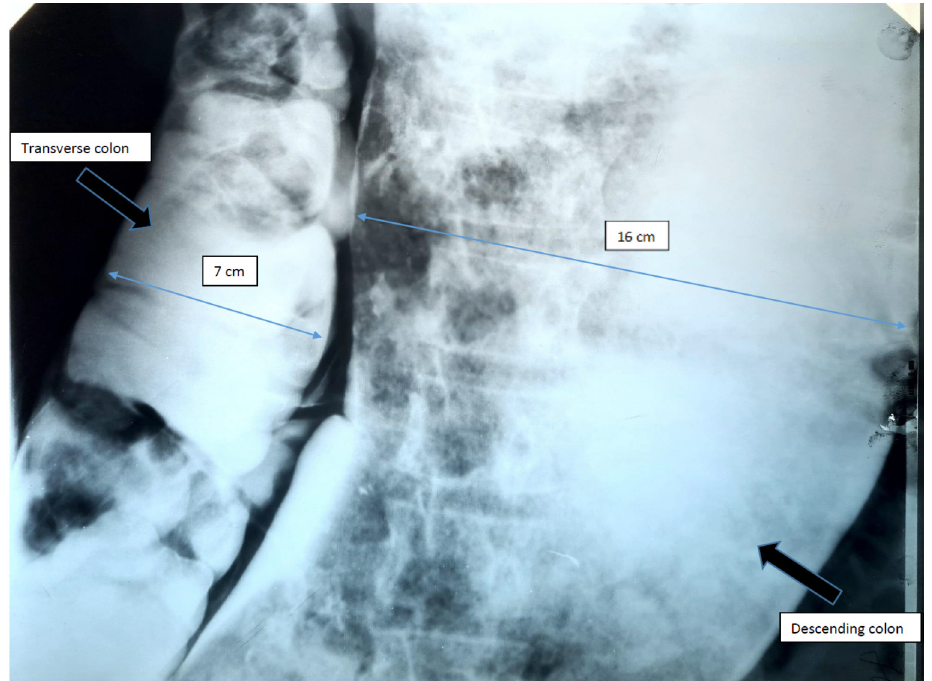
Figure 2. Irigographic examination — sequence. Monstrous segmental dilation located at the level of the descending colon and sigmoid is identified, the dimensional evaluation showing a lumen diameter of approximately 16 cm. It is noticeable the erasure of the haustrations and the envelopes of the colon, as well as numerous remains, organized in multiple faeces. Transverse colon slightly dilated, but with a caliber relatively within normal limits.